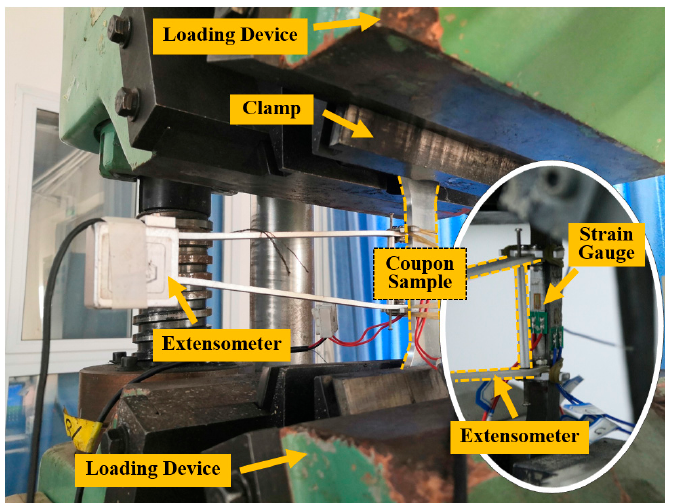
Figure 8. Real graphic of loading machine.